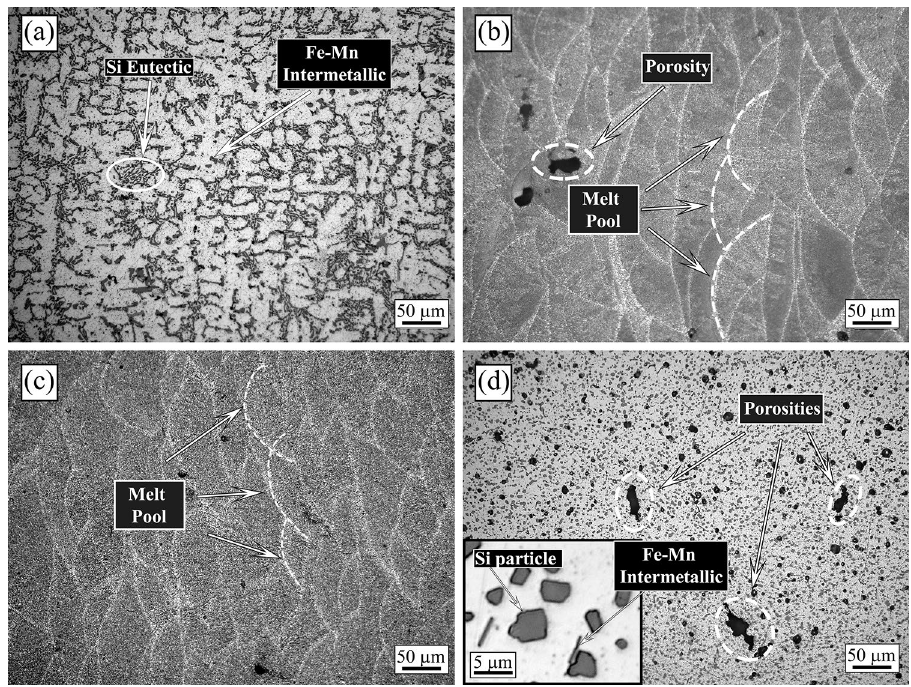
Figure 1. Optical microscope (OM) micrographs of the cast sample ( a ), as printed sample ( b ), annealed sample ( c ), solution treated sample ( d ) obtained at 200 × with Graff-Sargent etching